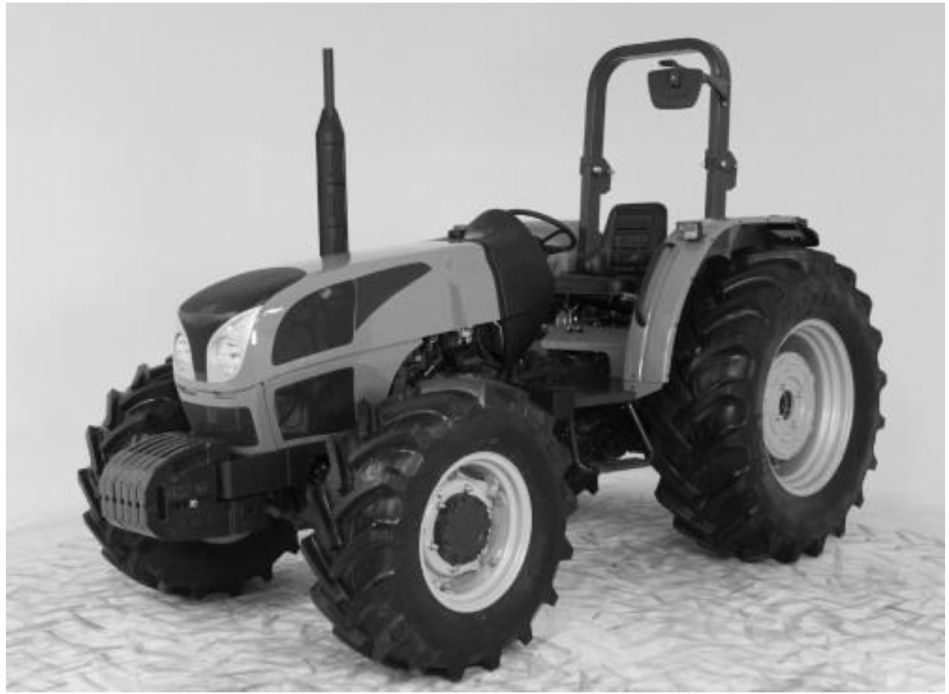
Figure 1. Example of a rear FROPS fitted on a standard tractor (track width > 1150 mm) in the upright